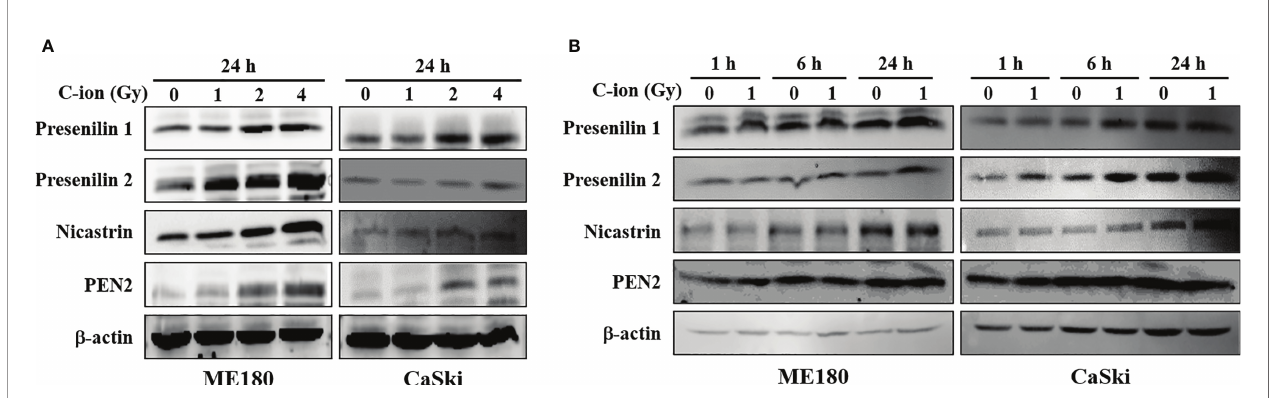
FIGURE 2 | The expression of g -secretase complex proteins was upregulated by C-ion. The cells were irradiated with 0, 1, 2 and 4 Gy of C-ion and the protein expression was detected by western blotting 24 h post-irradiation (A) or the cells were irradiated with 0 and 1 Gy C-ion and the protein expression was measured after 1, 6 and 24 h post-irradiation (B) . The images shown are the representatives of at least three independent experiments.